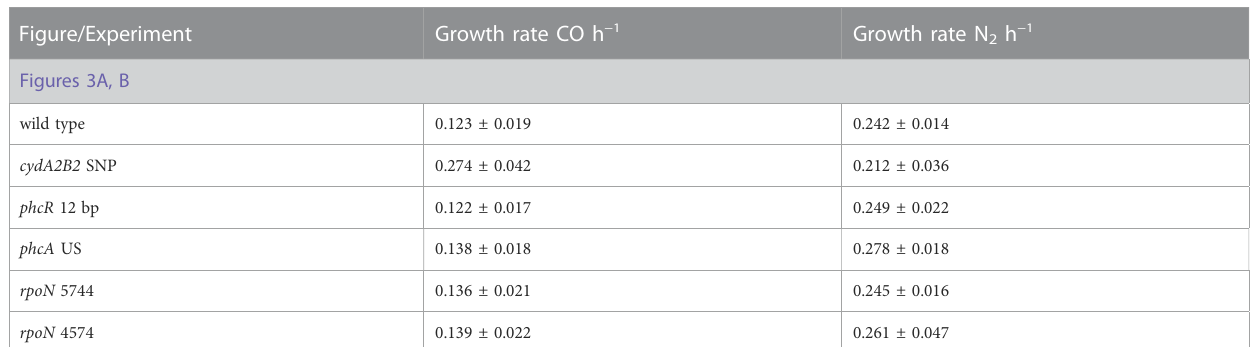
TABLE 4 Heterotrophic growth rates of the wild type H16 and its knock-in mutant derivatives.